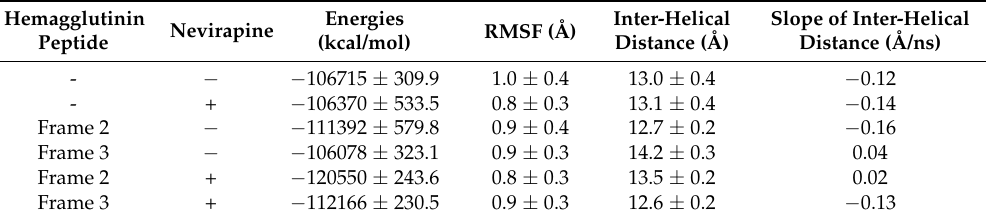
Table 1. Mean molecular dynamics (MD) simulations